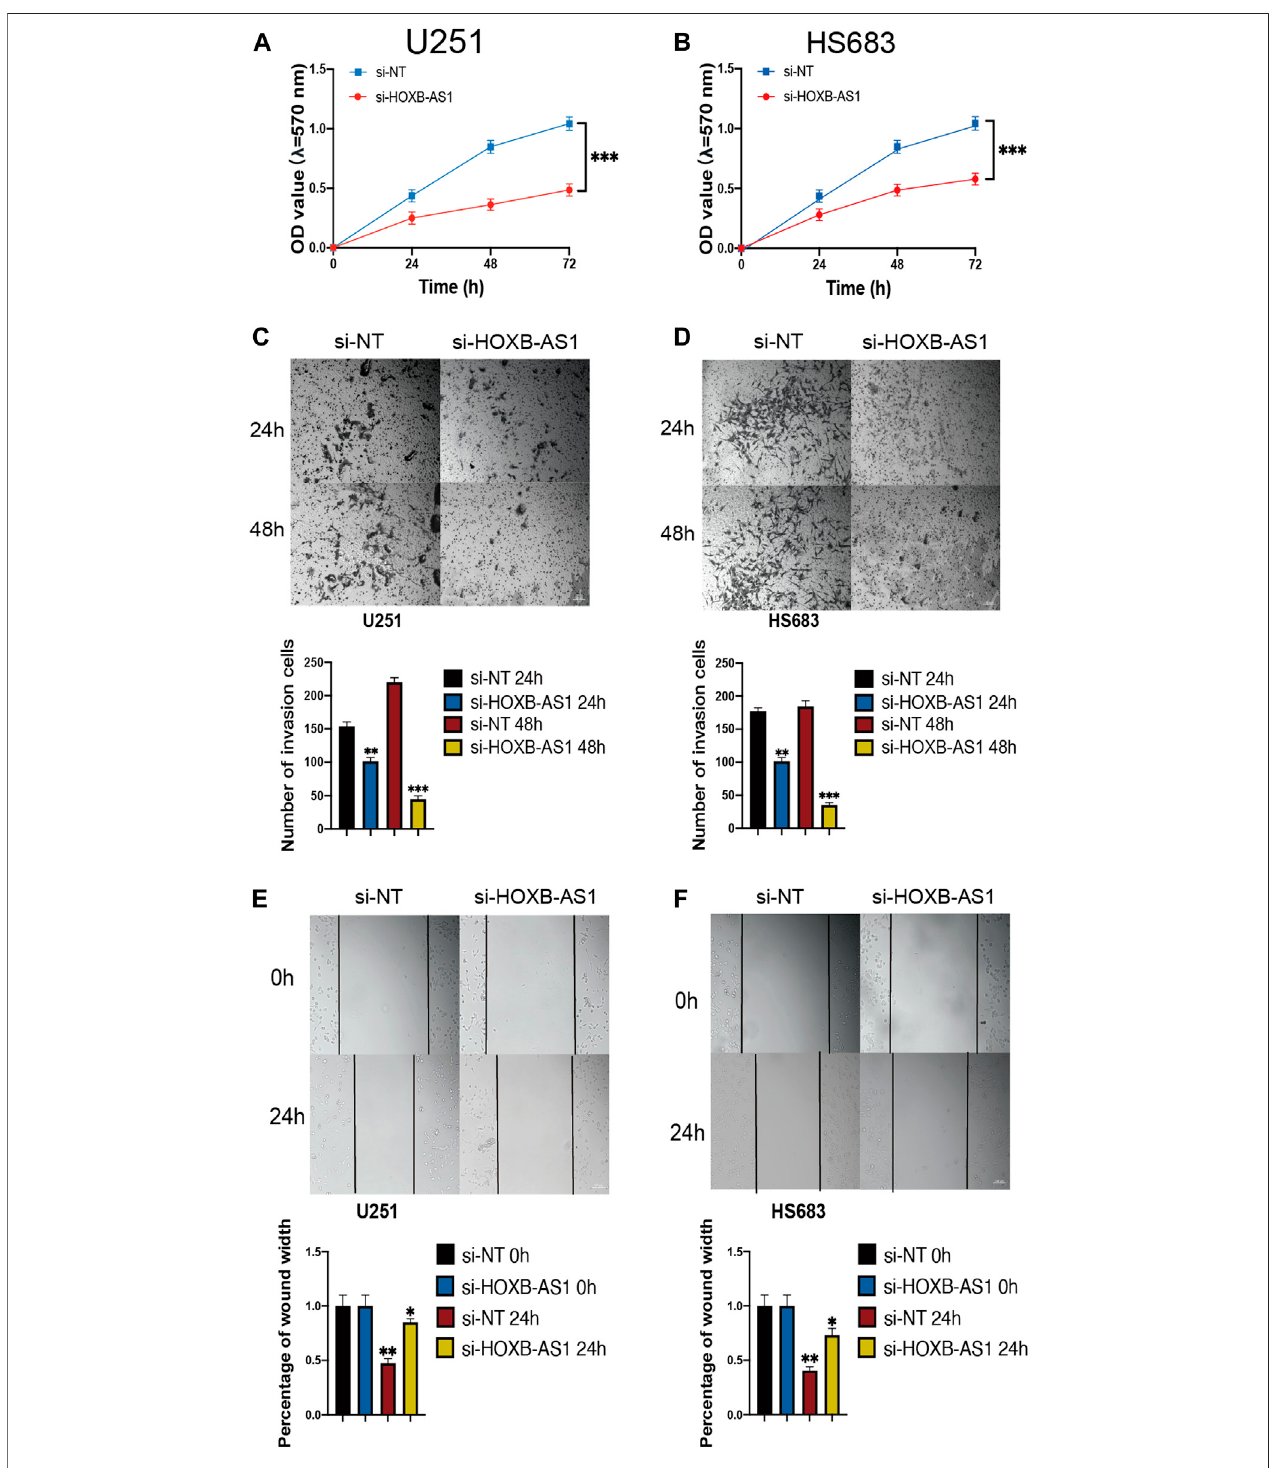
FIGURE 9 | the homeobox antisense transcripts (HOXATs) enhanced the progression of glioma cells. Knockdown of HOXB-AS1 inhibited glioblastoma proliferation, metastasis,and invasion. Cell viabilitywasmeasuredbyMTT assay inU251 and HS683 celllines, and cell viabilityofcells withHOXB-AS1knockdownwas signi fi cantly inhibited (A, B) . Transwell migration assay: HOXB-AS1 knockdown signi fi cantly decreased the migration distance in U251and HS683 cells (C, D) . Invasion capacity was measured after HOXB-AS1 downregulation by transwell assay in U251 and HS683 cells (E, F) . Bar: 100 μ m * p < 0.05, ** p < 0.01, *** p < 0.001.